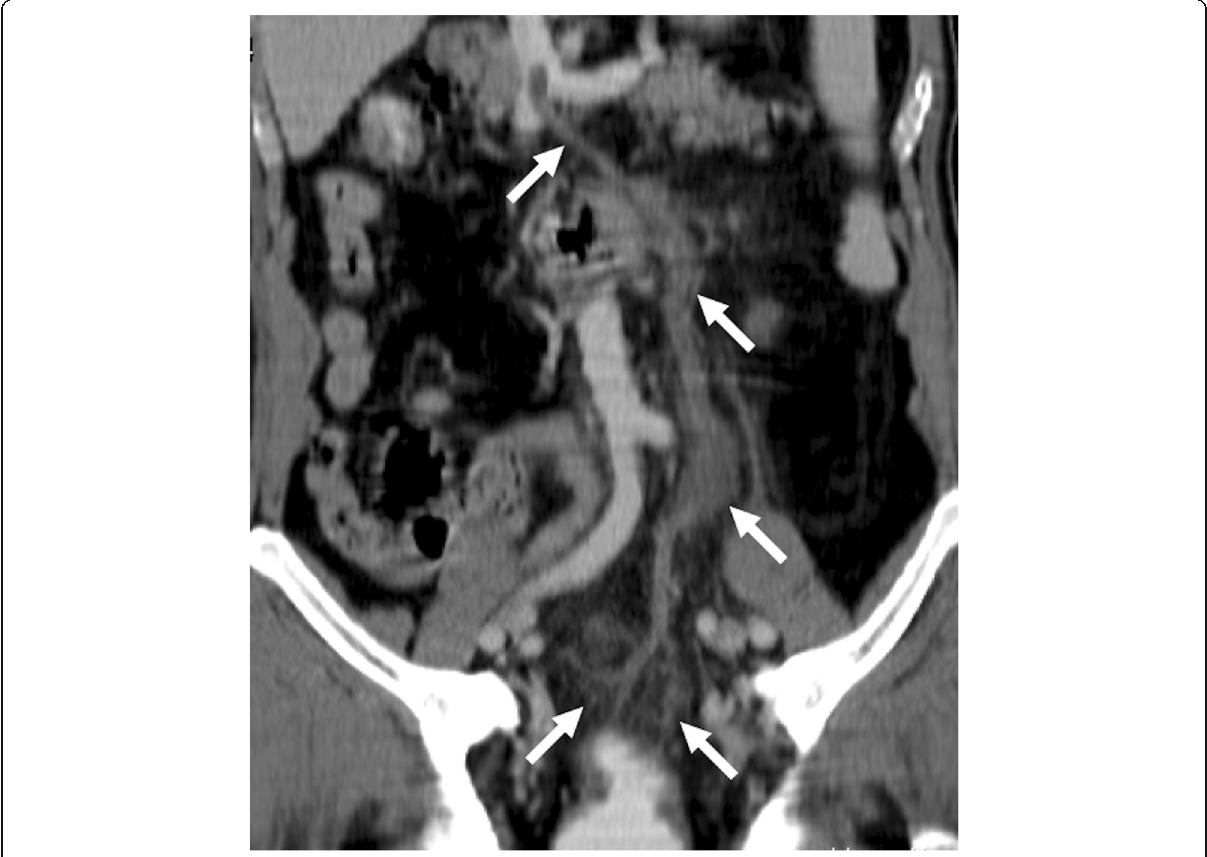
Fig. 6 IMV thrombosis. A 70-year-old man presented to ED with severe melena, fever, and abdominal pain. Coronally reformatted post-contrast CT image showed thrombosed IMV (arrows) due to sigmoid colon